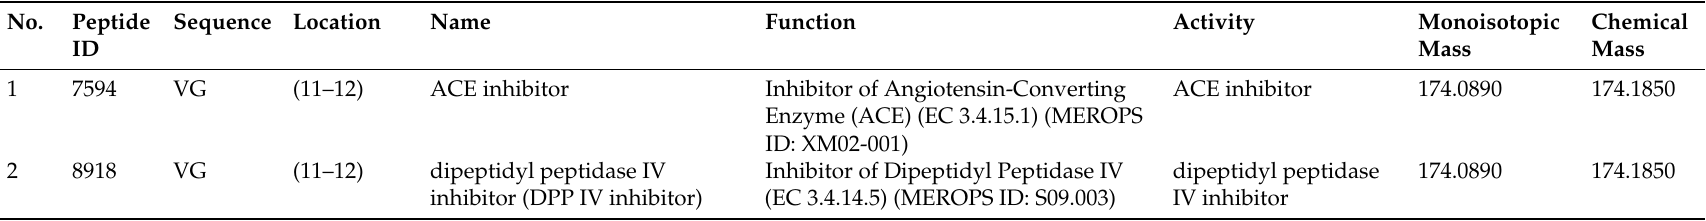
Table A43. Bioactive peptides from RubisCO of Halophila stipulacea . In silico enzymatic cleavage was carried out by using glycyl endopeptidase.